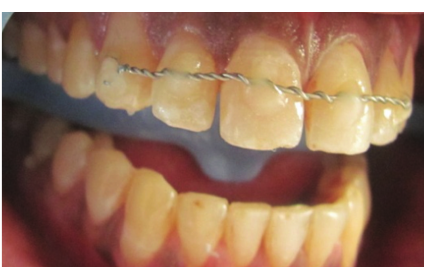
Figure 15: Splinting of teeth.